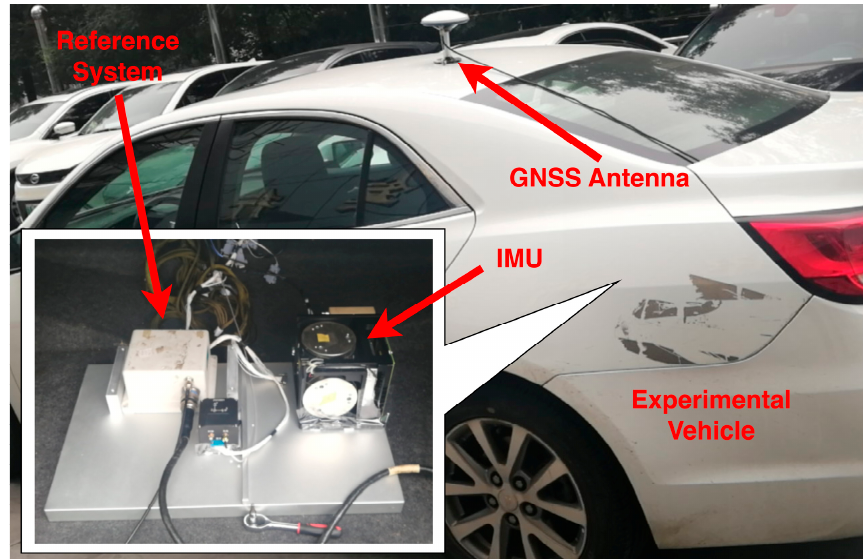
Figure 6. The experimental vehicle and equipment. Table 1. The specification of the inertial sensors.